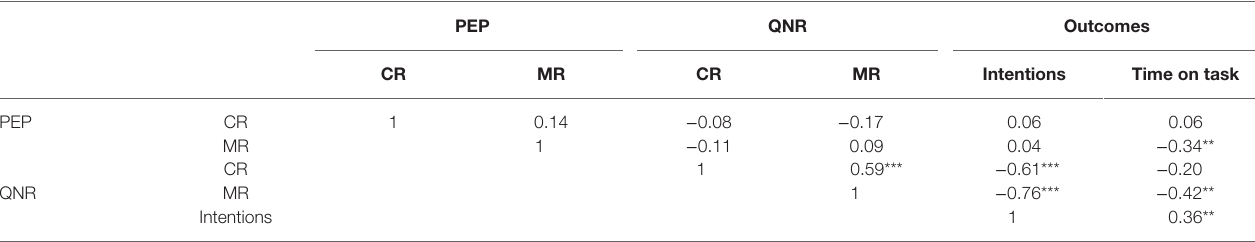
TABLE 2 | Correlations between PEP-based racism, questionnaire-based racism (QNR), and various outcomes in Experiment 2 (CR = Classic Racism, MR = Modern Racism).